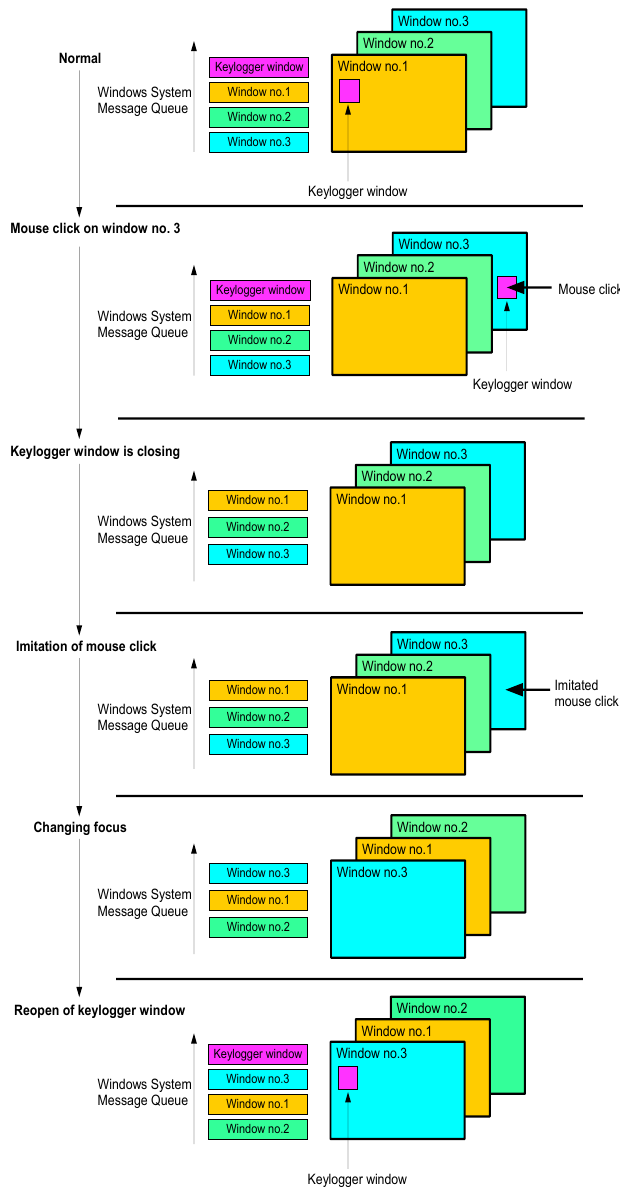
Figure 6. Changing window focus while Mouse Underlaying is active.